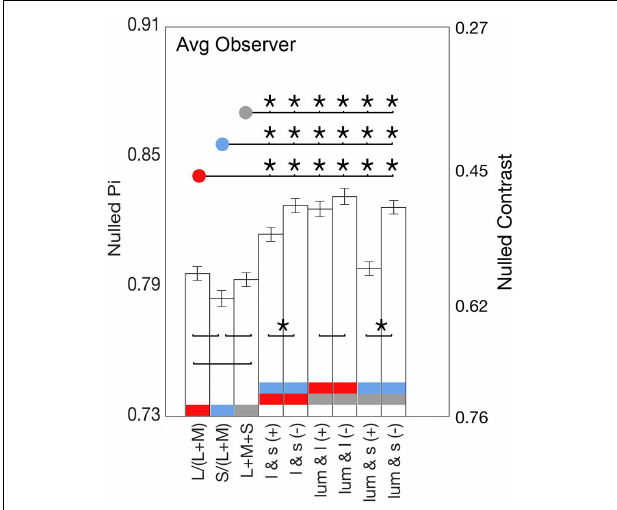
FIGURE 5 | Bars show the average identity points for the lowest contrasts of all nine axes. Significant Fisher comparisons between conditions ( p < 0.05) are connected with a line and marked with an asterisk (*); those that lack an asterisk were not statistically significant ( p > 0.05). Comparisons between cardinals and between positive slope (same polarity) and negative slope axes (opposite polarity) are over the bars, whereas comparisons between cardinal and non-cardinal axes are above the bars.